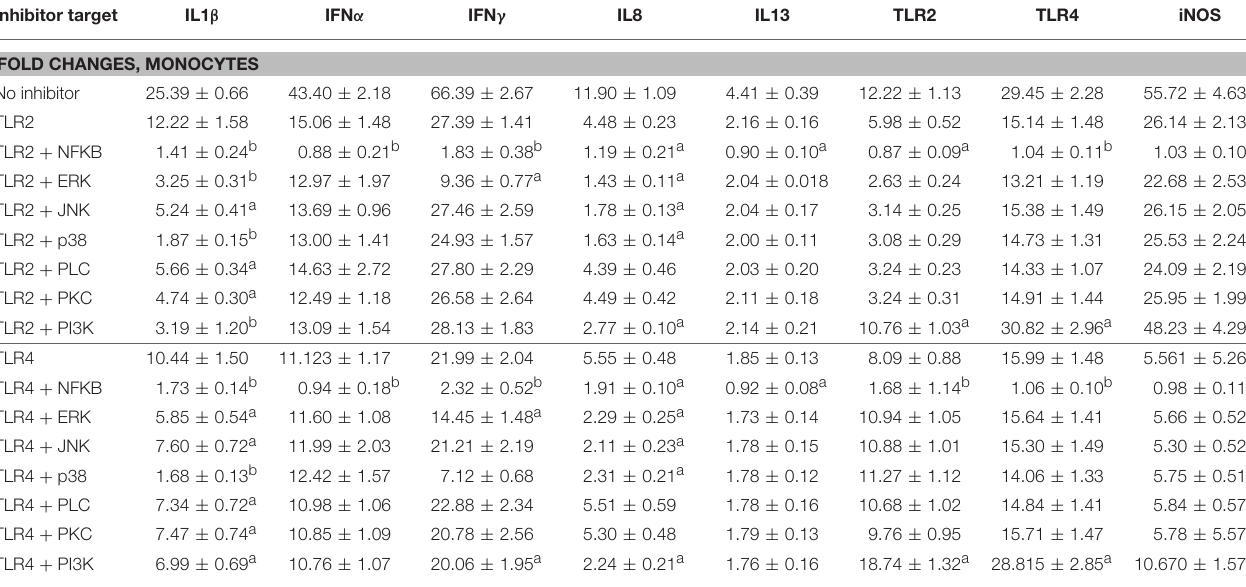
TABLE 8 | TLR2 and TLR4 pathways regulate transcription in monocytes through common intracytoplasmic mediators. Inhibitor target IL1 β IFN α IFN γ IL8 IL13 TLR2 TLR4 iNOS FOLD CHANGES,